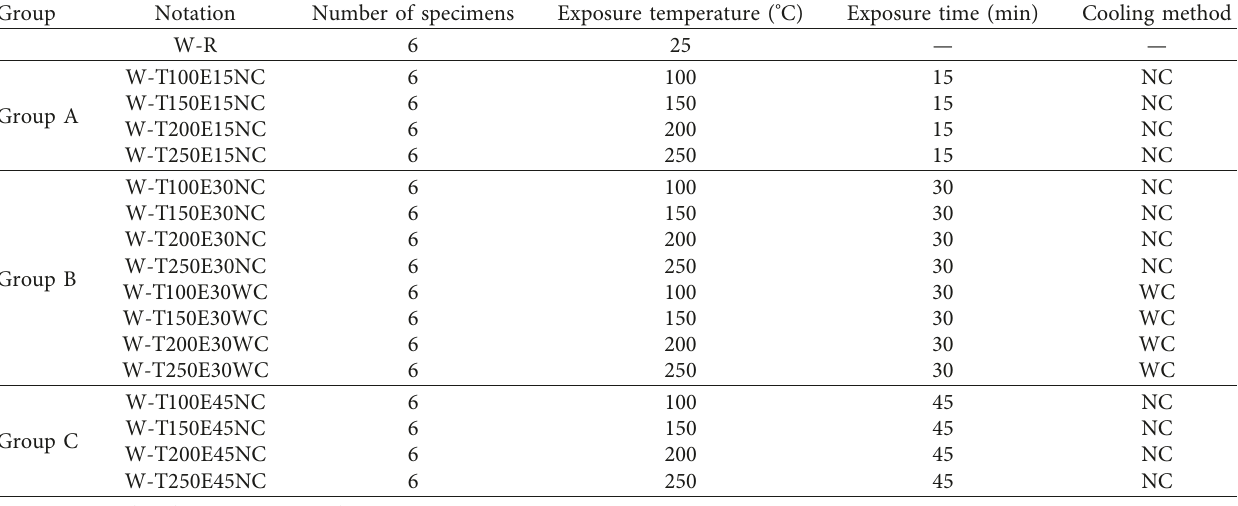
Table 1: Details of wood specimens for each